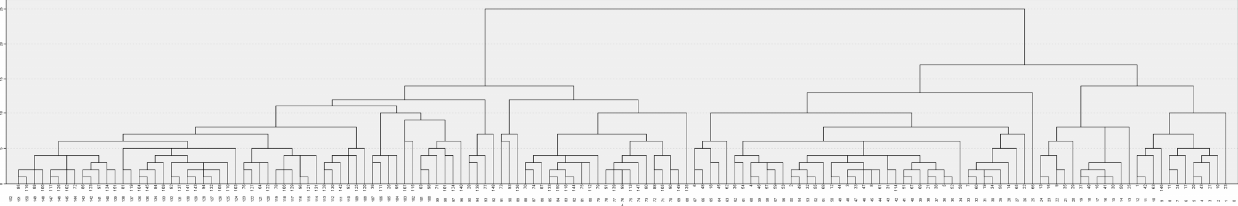
Figure 1. Dendrogram. Figure 1.